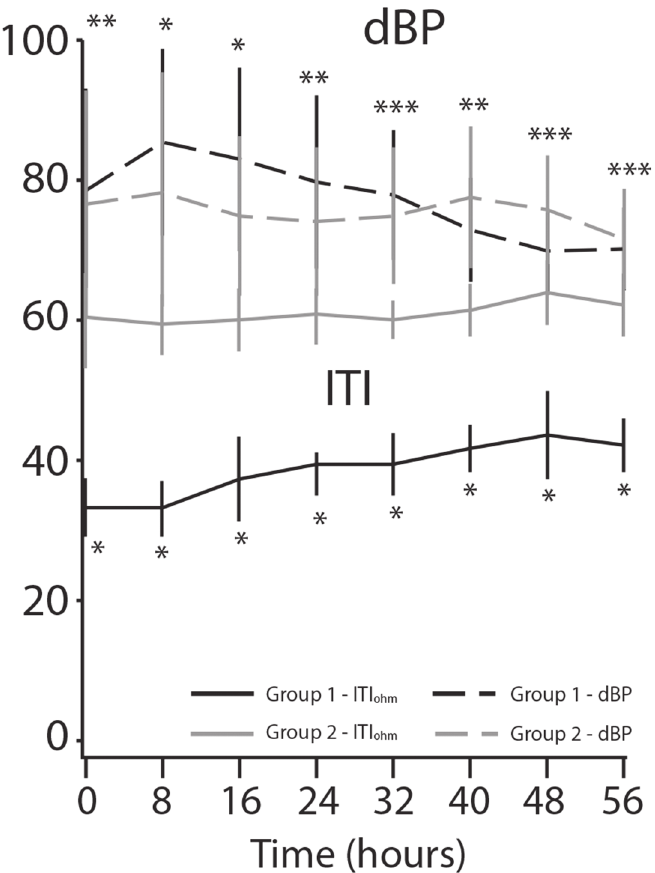
Fig 7. Diastolic blood pressure (dBP) and internal thoracic impedance (ITI) changes over time. * P - value < 0.0001. ** P -value < 0.01. *** P -value = non-significant.